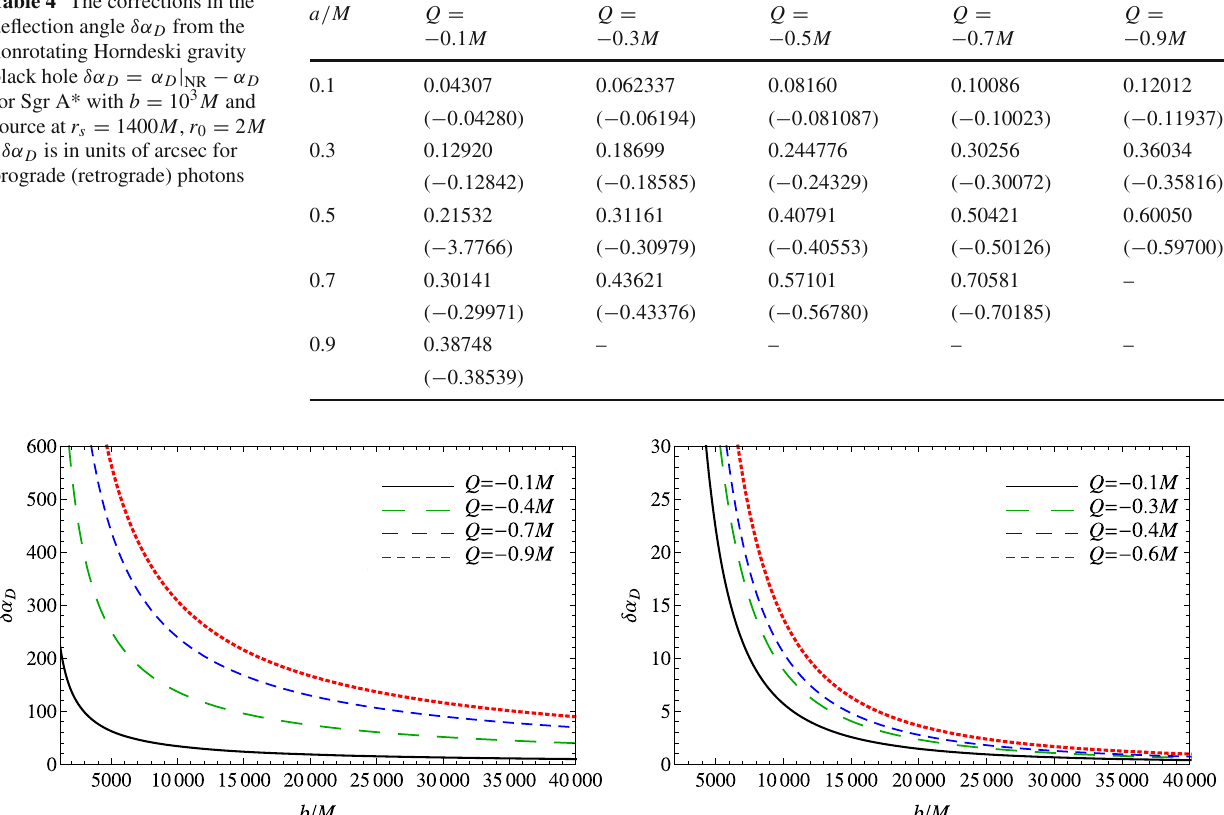
δα D from nonrotating Horndeski black holes a = 0 . 50 M , and varying b ; δα D is in units of mas